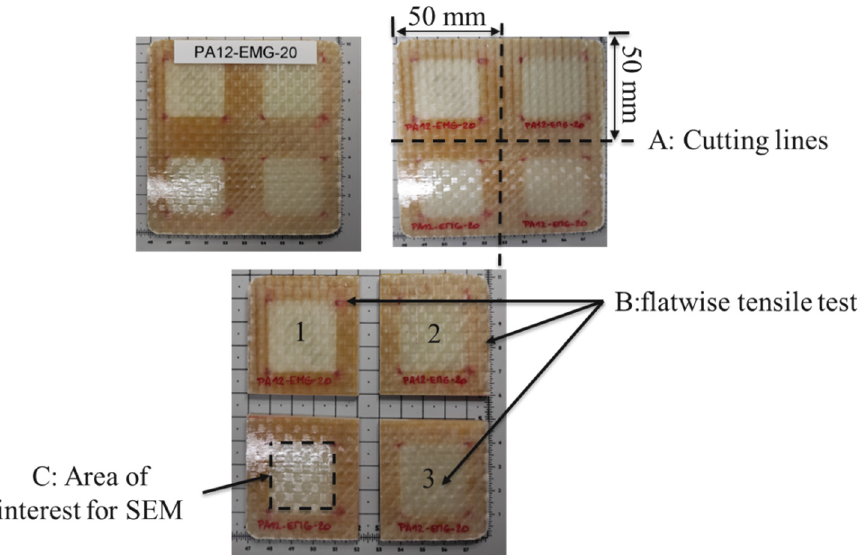
Figure 5. ( A ) Cutting configuration, ( B ) specimens for flatwise tensile test (1, 2, and 3), ( C ) area of interest for Scanning Electron Microscopy (SEM).